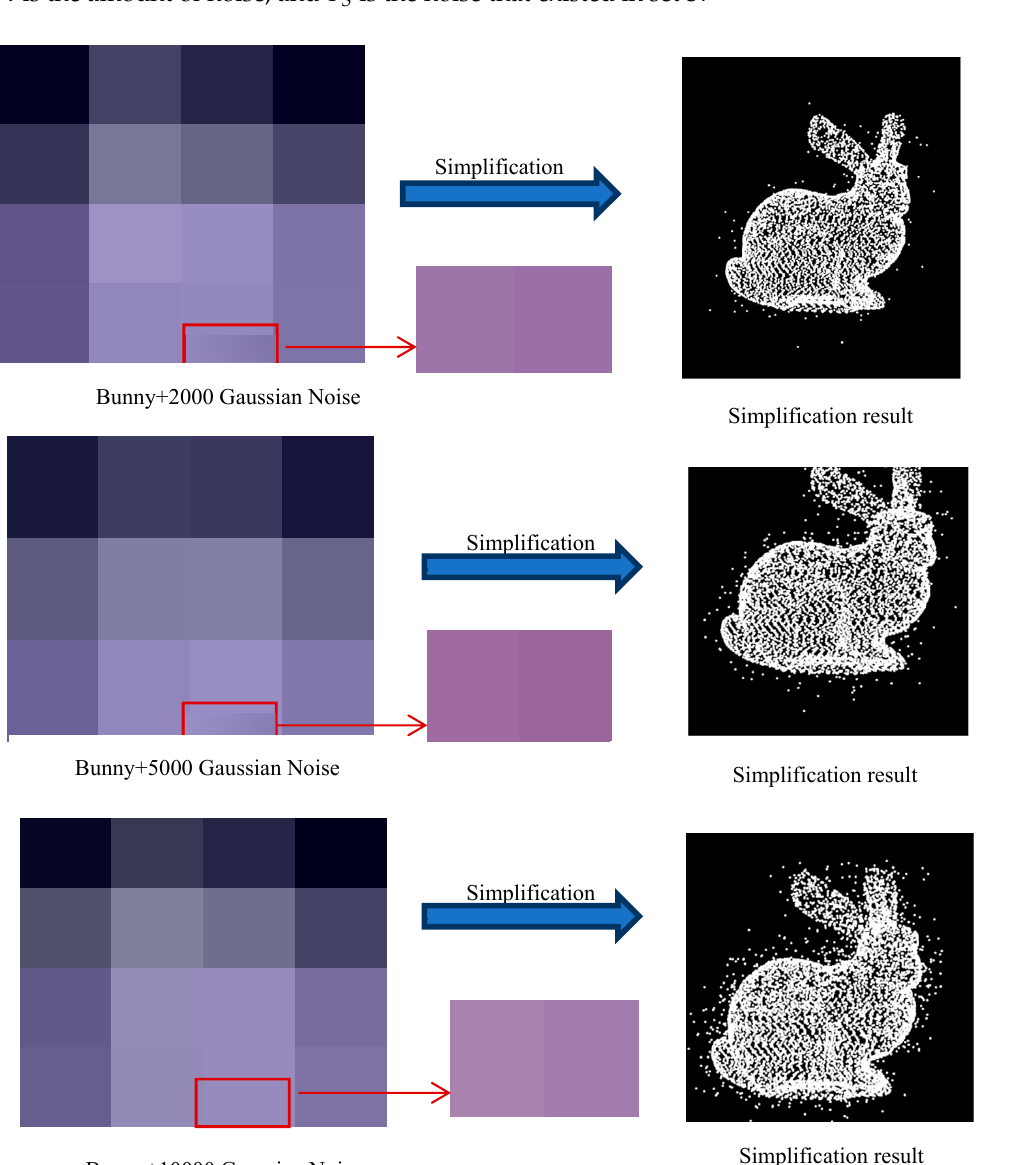
Figure 18. The robustness of the FPPS experimental results.